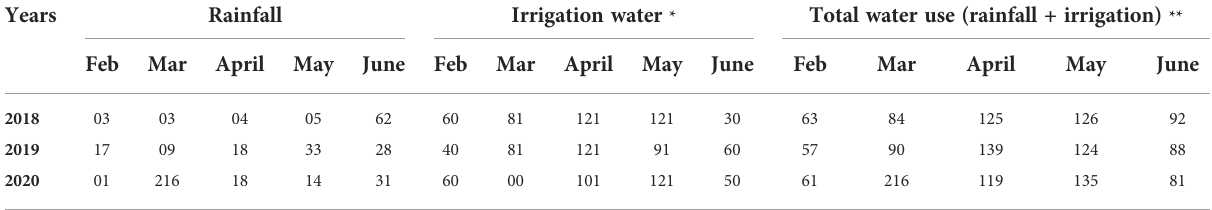
TABLE 2 Rainfall (mm), irrigation water (mm), and total water use (mm) of maize and soybean under sole and intercropping systems at the experimental site of Sichuan Agricultural University, Bahawalpur, South Punjab, Pakistan. Rainfall Irrigation water *